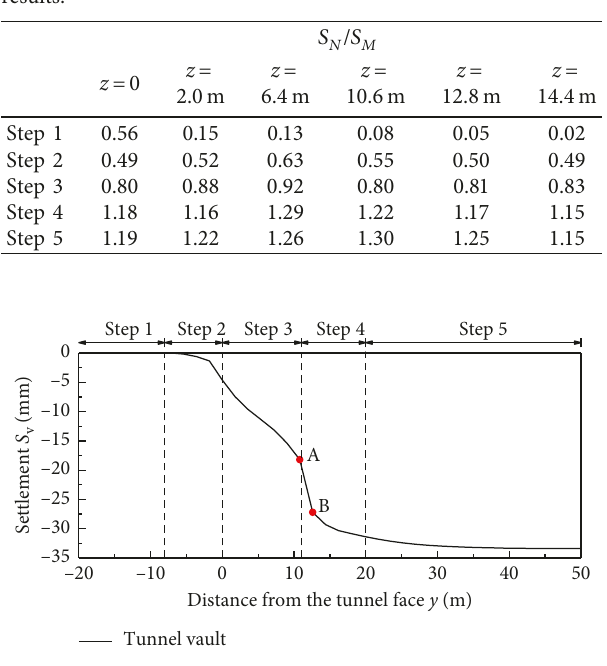
Figure 16: Settlement of the tunnel vault during the tunnelling process (the numerical result).